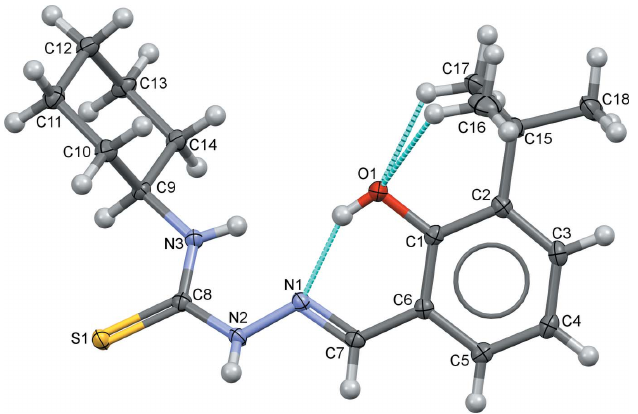
Figure 1 The molecular structure with the atom-labelling scheme and displace- ment ellipsoids at the 50% probability